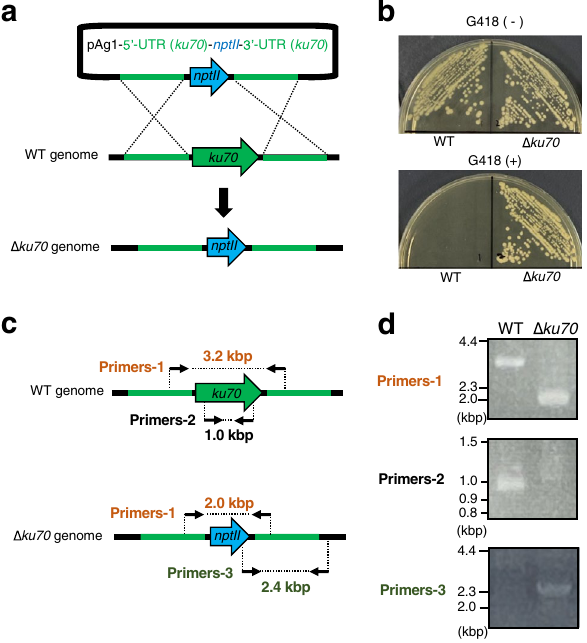
Figure 2. Construction of the ku70 gene-deficient mutant in the T. asahii MPU129 strain by the ATMT system. ( a ) Structure of the plasmid used to construct the ku70 gene-deficient mutant and the predicted genome of the ku70 gene-deficient mutant. ( b ) The wild-type (MPU129) and ku70 gene-deficient candidate were spread on Sabouraud agar medium with or without G418 (50 µg/ml) and incubated at 27 °C for 2 days. ( c ) Location of the primers for confirming the genome structure of the ku70 gene-deficient candidate by PCR. ( d ) Confirmation of the ku70 gene-deficiency of the ku70 gene-deficient candidate by PCR using extracted genome DNA. Cropped blots were used. Full-length blots are presented in Supplementary Fig.